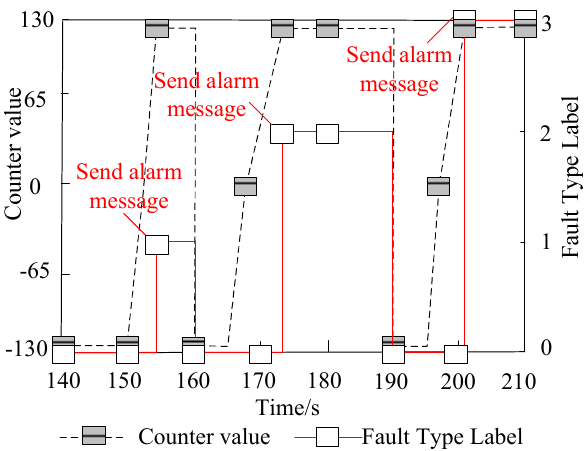
vehicle model are shown in Figure 13.